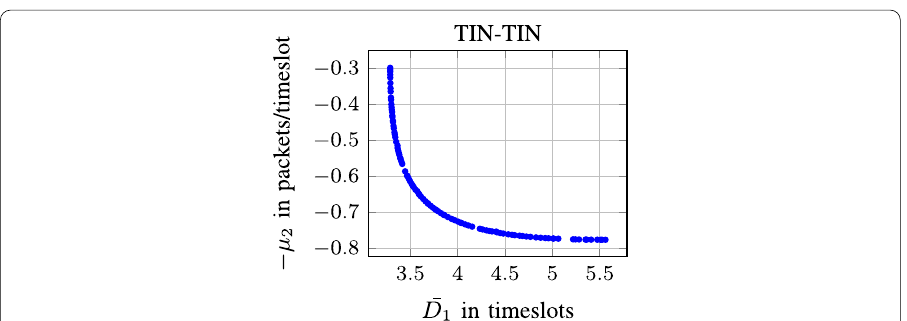
Fig. 9 Pareto set for (19) in TIN-TIN. The rest of the parameters are the following: (cid:31) 1 = 0.1 , γ 1 = − 4.2dB , γ 2 = − 6.4dB , α = 2.2 , β = 41dB , P J = 23dB , B = 6 packets, P max = 23dB , d 2 = 14.6m , and d 12 = 10m . In TIN-TIN, d 1 =